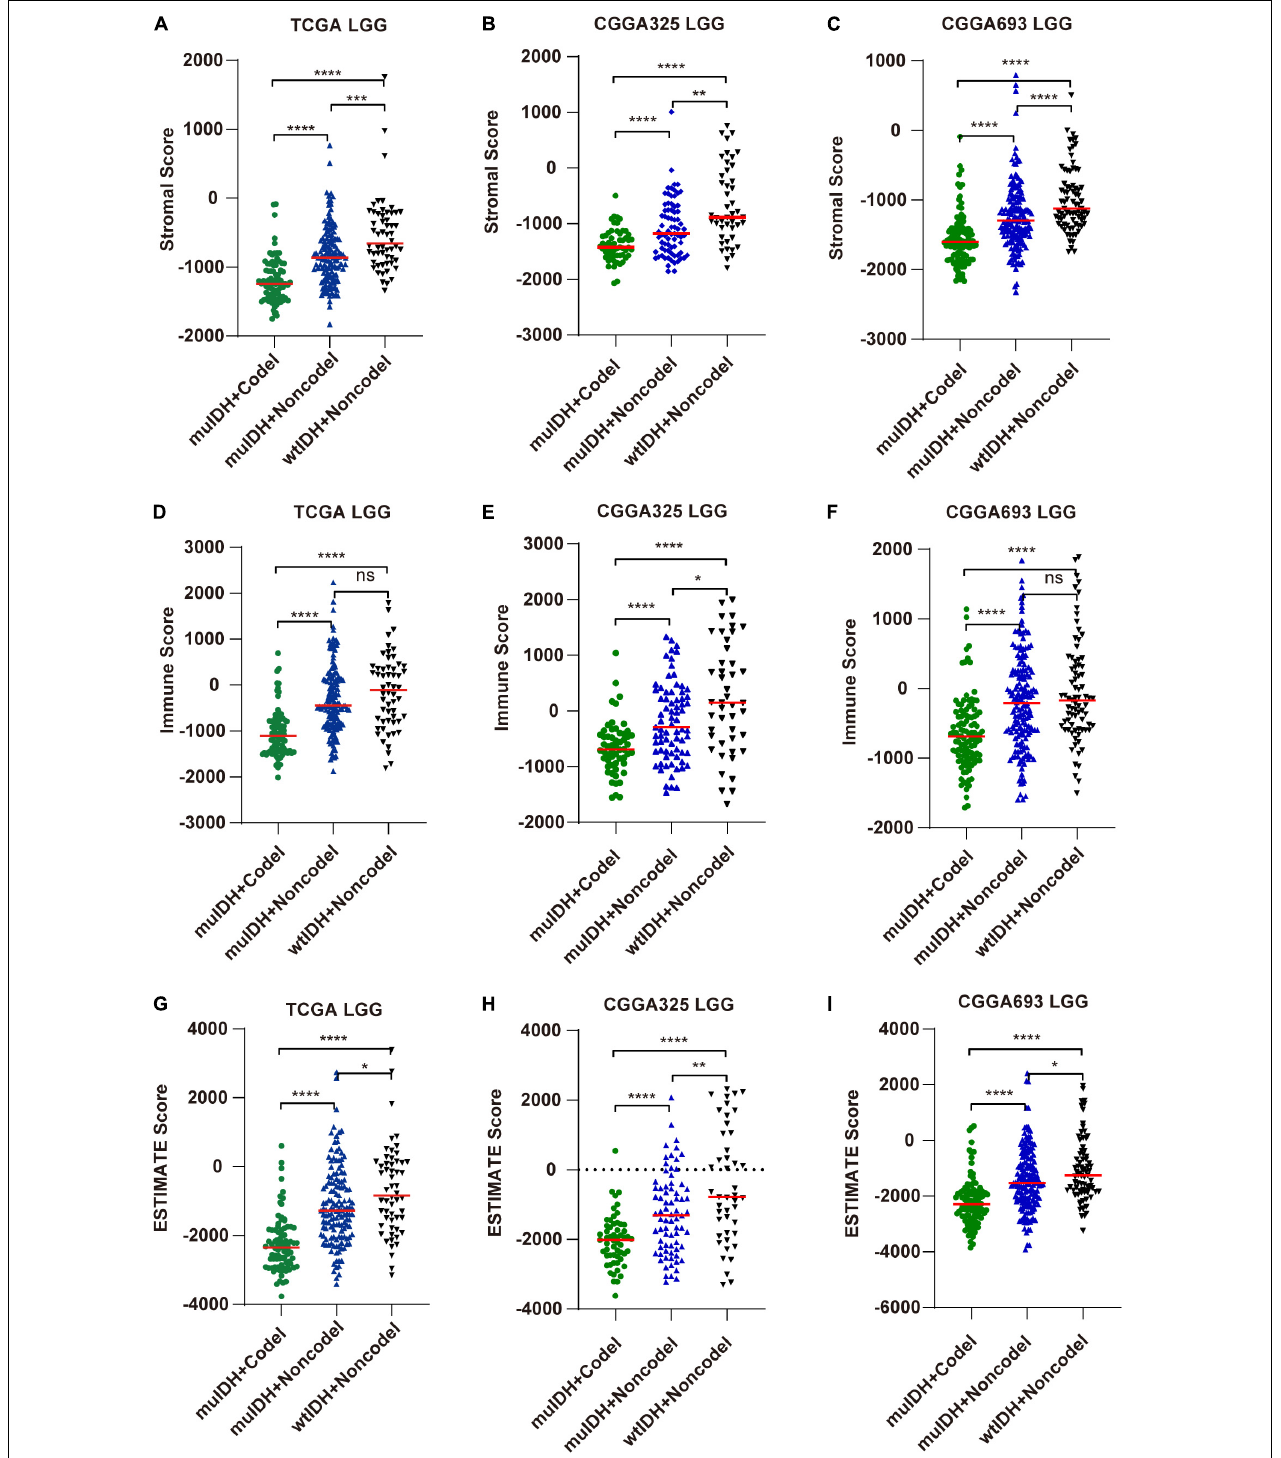
FIGURE 3 | Estimating the infiltrating level of stromal cells, immune cell, and tumor purity in LGG using ESTIMATE algorithm. (A–C) Stromal score (positively correlated with the level of stromal cell in tumor) of samples in different subgroups in TCGA LGG (A), CGGA325 LGG (B) , and CGGA693 LGG (C) . (D–F) Immune score (positively correlated with immune cell infiltration in tumor) of samples in different subgroups in TCGA LGG (D), CGGA325 LGG (E) , and CGGA693 LGG (F) . (G–I) ESTIMATE score (negatively correlated with tumor purity) of samples in different subgroups of LGGs in TCGA LGG (G) , CGGA325 LGG (H) , and CGGA693 LGG (I) . Each symbol represents an individual patient. The number of patients in each subgroup was shown in Figure 1 . The mean scores are indicated by red lines. P values are inferred from a two-sided Student’s t -test or Mann-Whitney test. * p < 0.05, ** p < 0.01, *** p < 0.001, **** p < 0.0001.